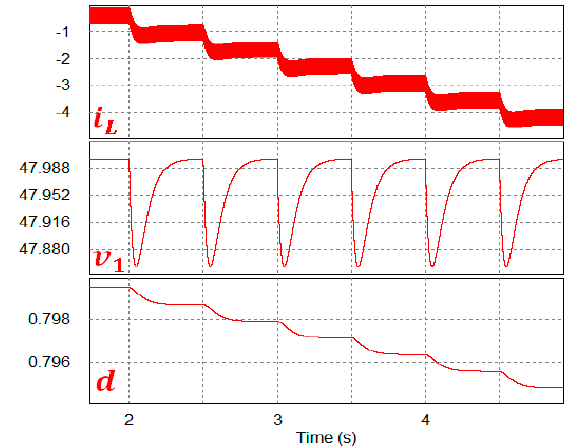
Figure 12. Simulated waveforms during validation test of the buck mode.